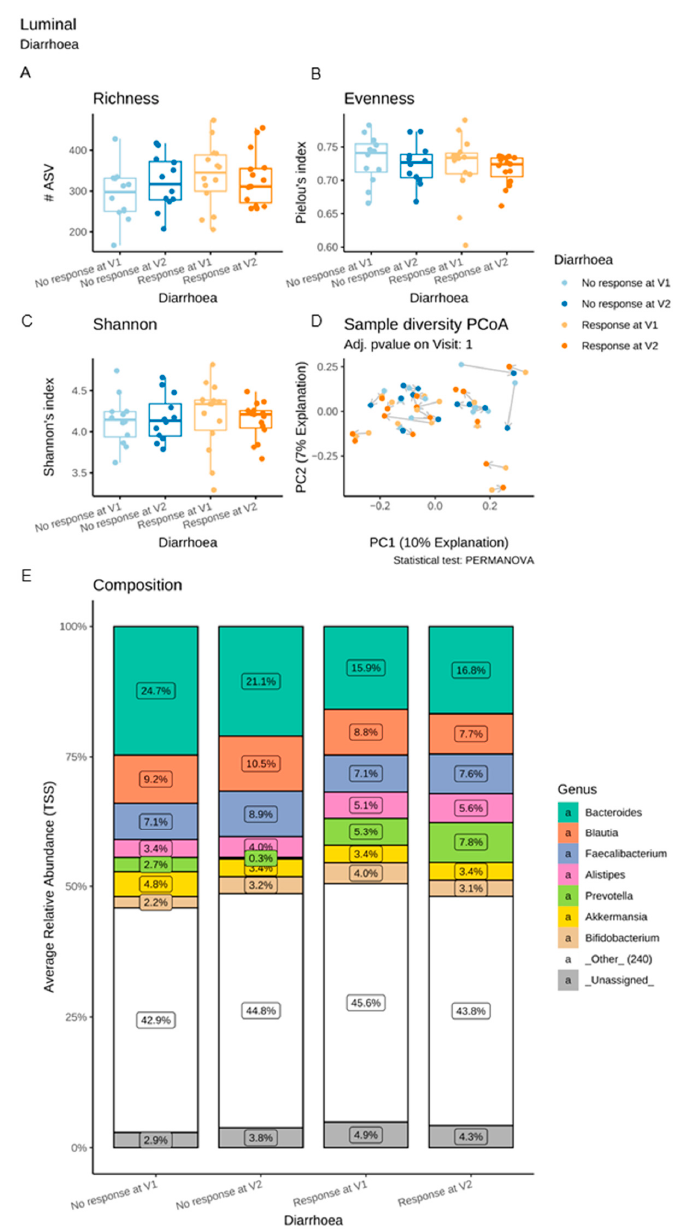
Figure 8. Impact of a 4-week supplementation with the multistrain probiotic on the luminal gut microbiota in Diarrhoea responders (R) and non-responders (NR). ( A – C ) α -diversity, estimated by the richness (number of observed ASVs) ( A ), evenness (Pielou’s index) ( B ) and Shannon’s index ( C ); ( D ) principal coordinate analysis (PCoA) of bacterial β -diversity, measured according to the Bray– Curtis distance; ( E ) bacterial taxonomic profile at genus level before (V1) and after (V2) supplemen- tation.